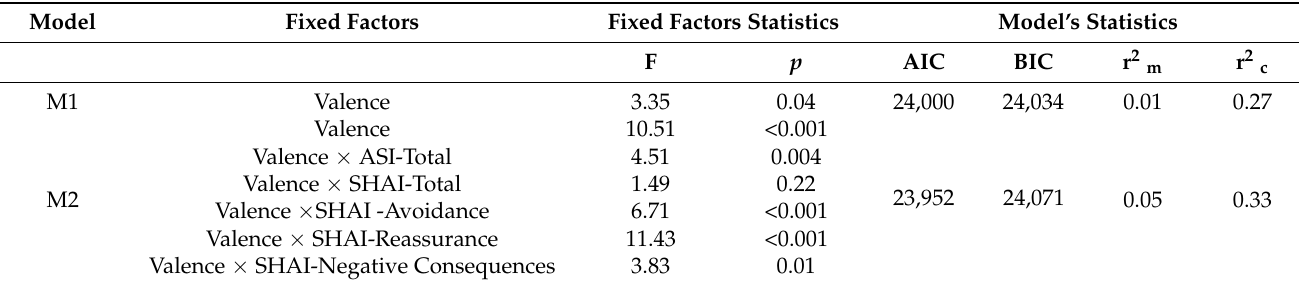
Table 2. M1 investigates the main effect of valence (positive vs. neutral vs. negative) on RTs. M2 tests the interaction between valence and ASI and SHAI’s subscales scores.